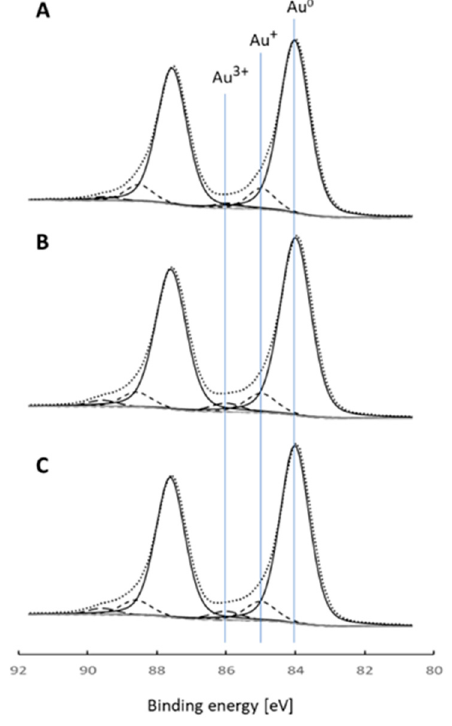
Figure 3. XPS results for Au 4f detailed regions of the catalysts: ( A ) Au / Ce 0.85 Zr 0.15 O 2 , ( B ) Au + 0.3 at%/Ce 0.85 Zr 0.15 O 2 , and ( C ) Au + 0.6 at%K/Ce 0.85 Zr 0.15 O 2 .